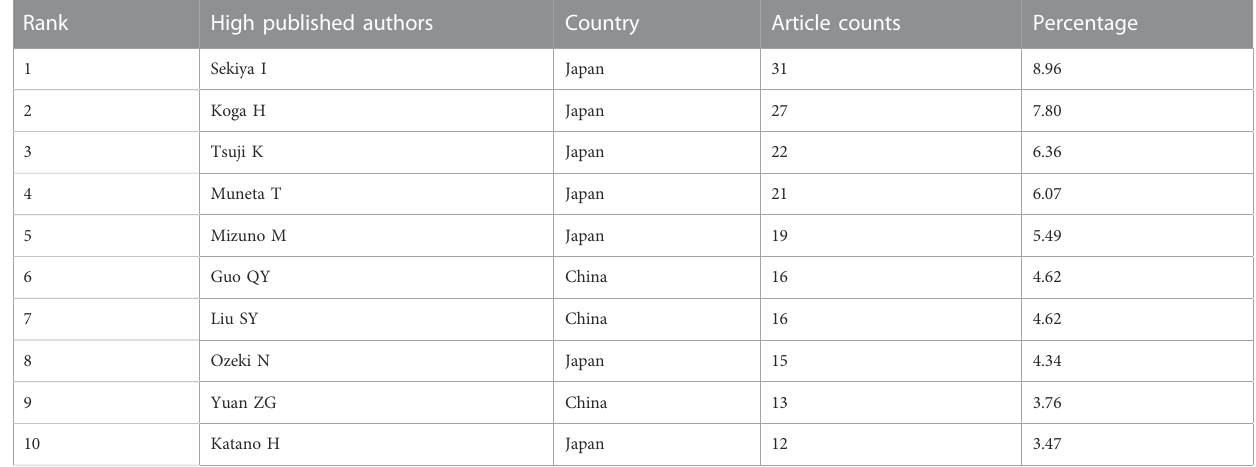
TABLE 9 The top 10 authors with the most publications on stem cells for meniscal regeneration.